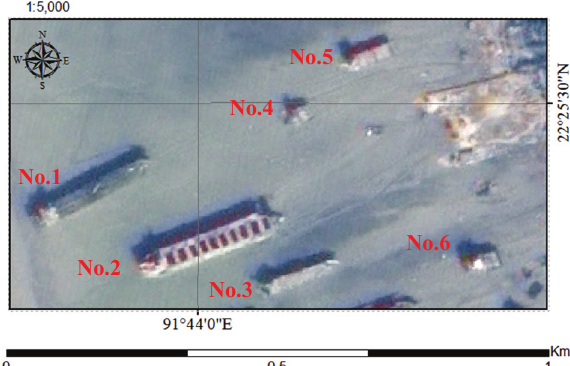
Figure 3. ALOS Pan-sharpen (PRISM/AVNIR-2) imagery capturing breaking-ship figure at 1:5,000